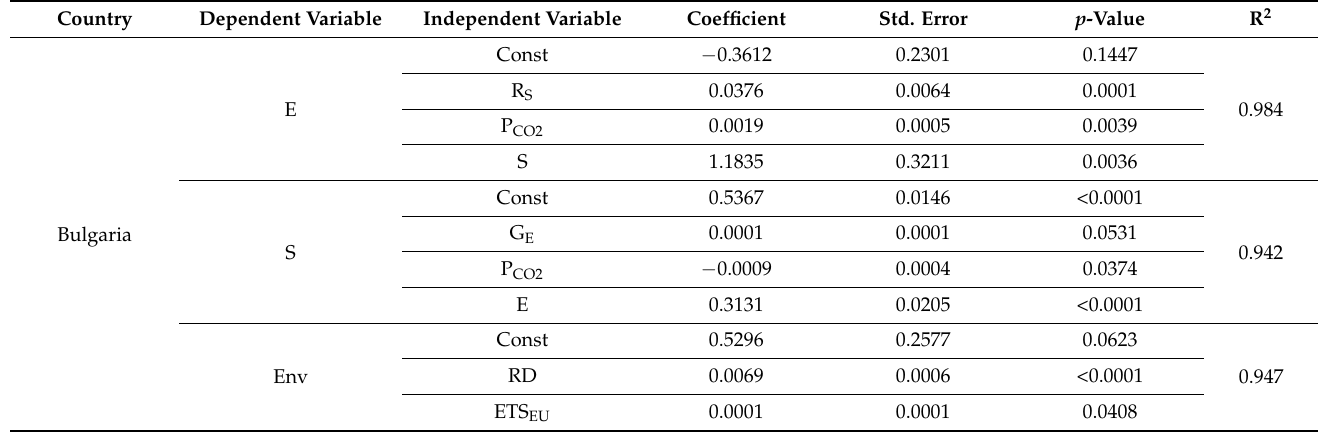
Table 5. Results of OLS regressions in the analyzed countries from 2008 to